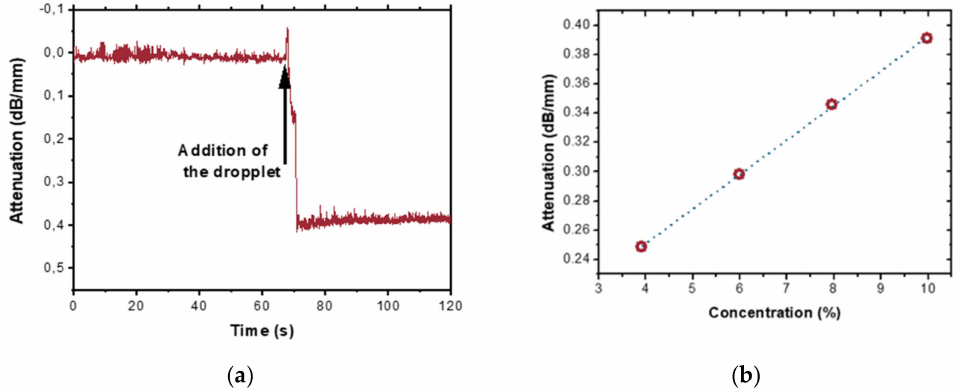
Figure 5. Sensing demonstration ( a ) Example of a sensor experiment where a droplet of 10 wt.% ethanol / water solution has been applied to the tapered section of the waveguide. ( b ) TM-polarized light absorption induced by the water / ethanol solution droplets on the sensor surface at λ = 3.68 µ m wavelength as a function of ethanol